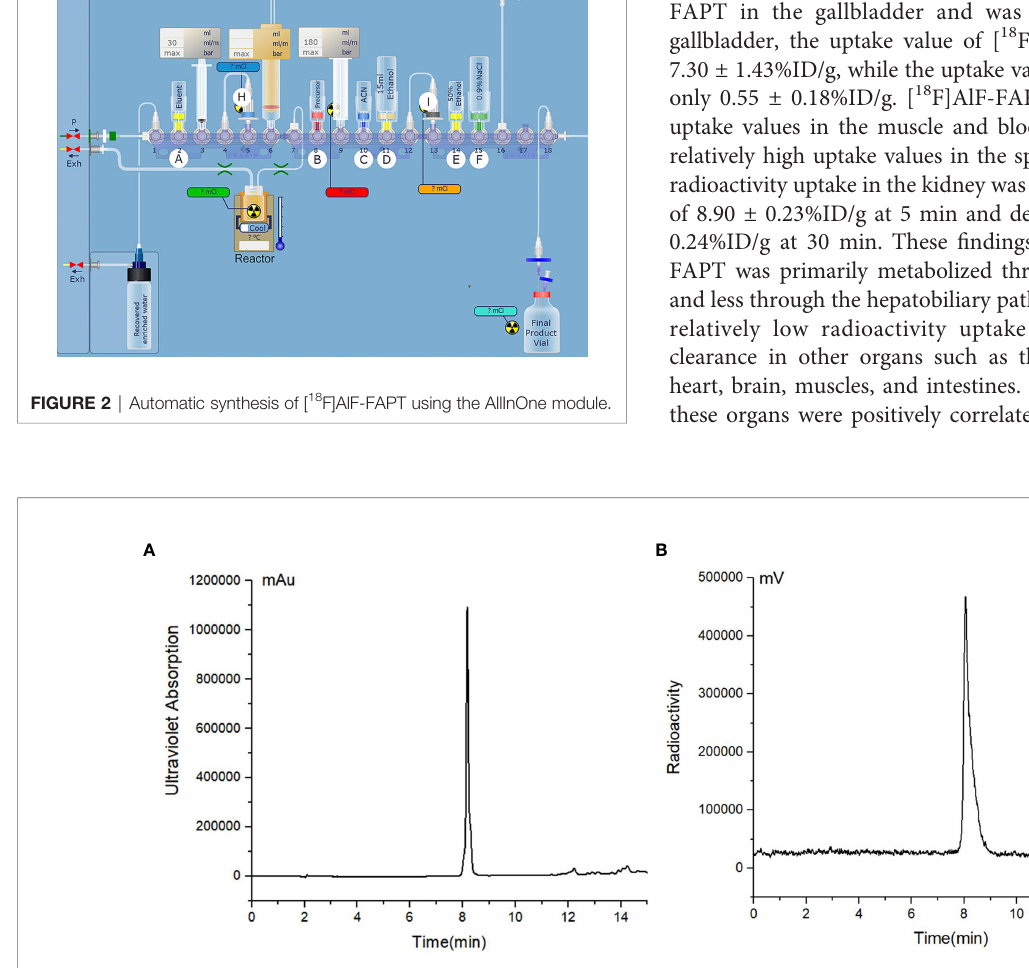
FIGURE 3 | (A) HPLC chromatograms of standard unlabeled [ 19 F]AlF-FAPT; (B) HPLC chromatograms of [ 18